Question: Give a one-sentence summary of this figure.
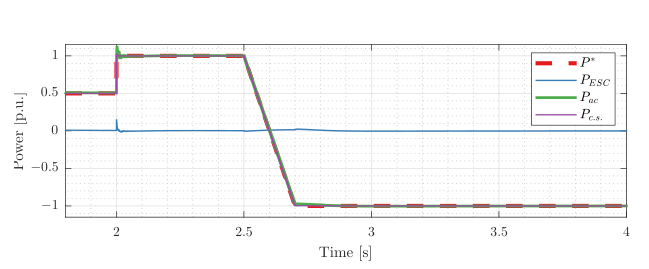
Answer: Active power reference step simulation results in [p.u.] with Sbase.